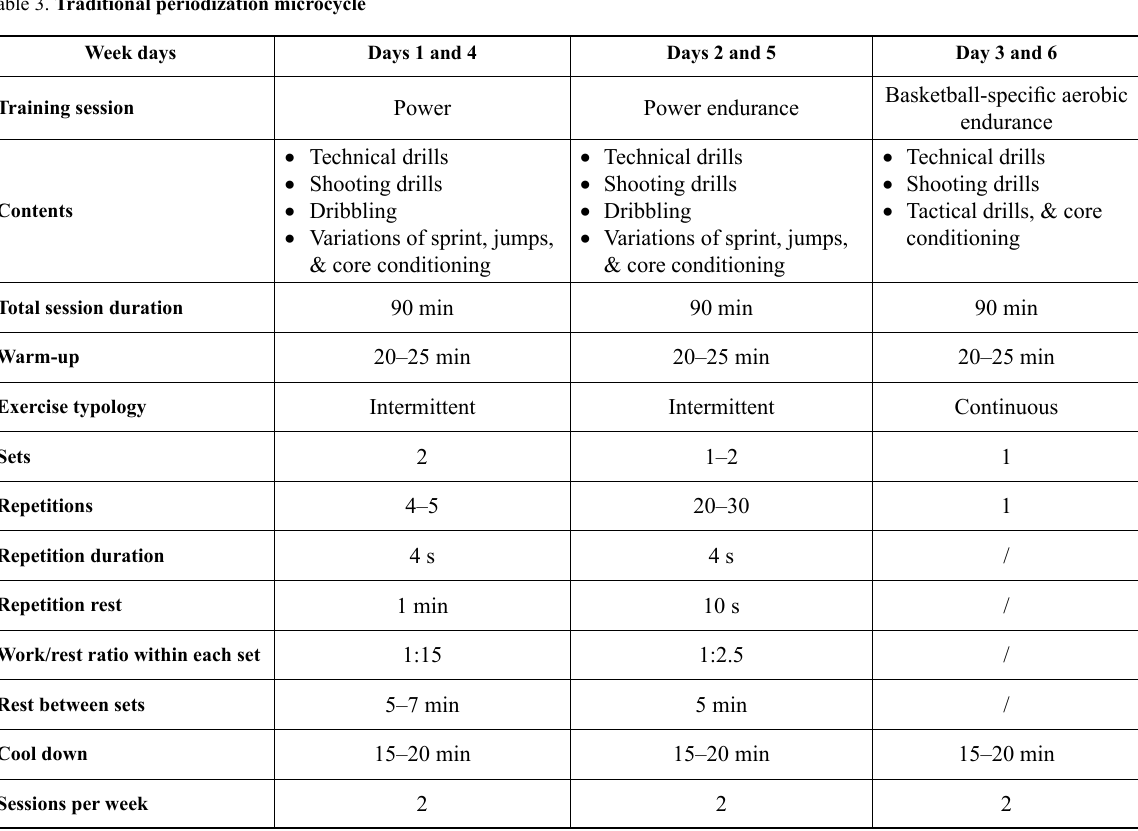
Table 3. Traditional periodization